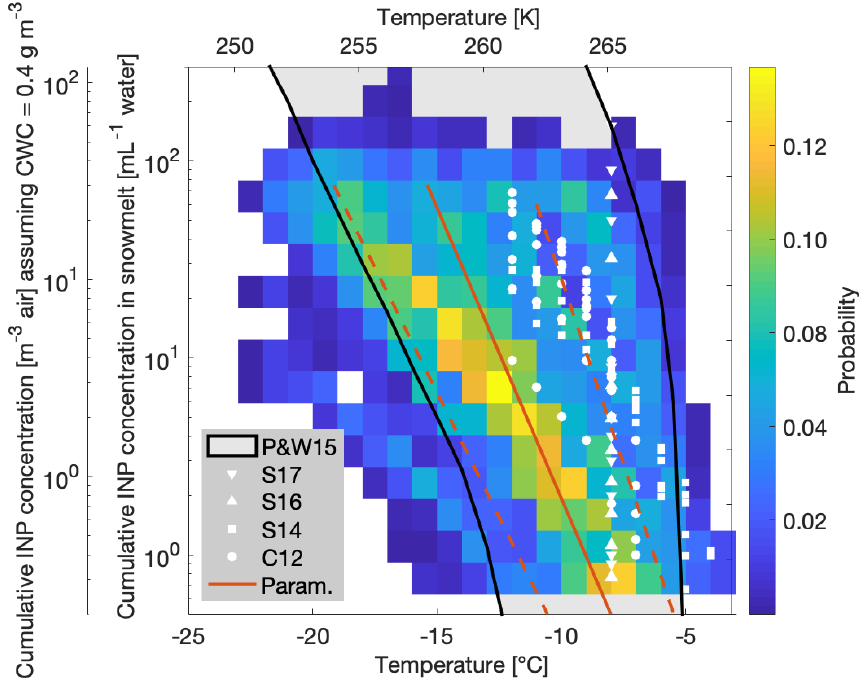
Figure 11. Observations in INP concentrations in snowmelt ( n sm ) and in air ( c air ) for all of the measurements (88 samples) as a function of temperature. The observations are shown as probability in a two-dimensional histogram. The grey area with black borders shows the concentrations found in the literature (Petters and Wright, 2015). The white symbols correspond to other field studies in the Swiss Alps (Conen et al., 2012; Stopelli et al., 2014, 2016, 2017), with the parameterizations n ∗ sm (T ) and c ∗ deviations) thereof (dashed).